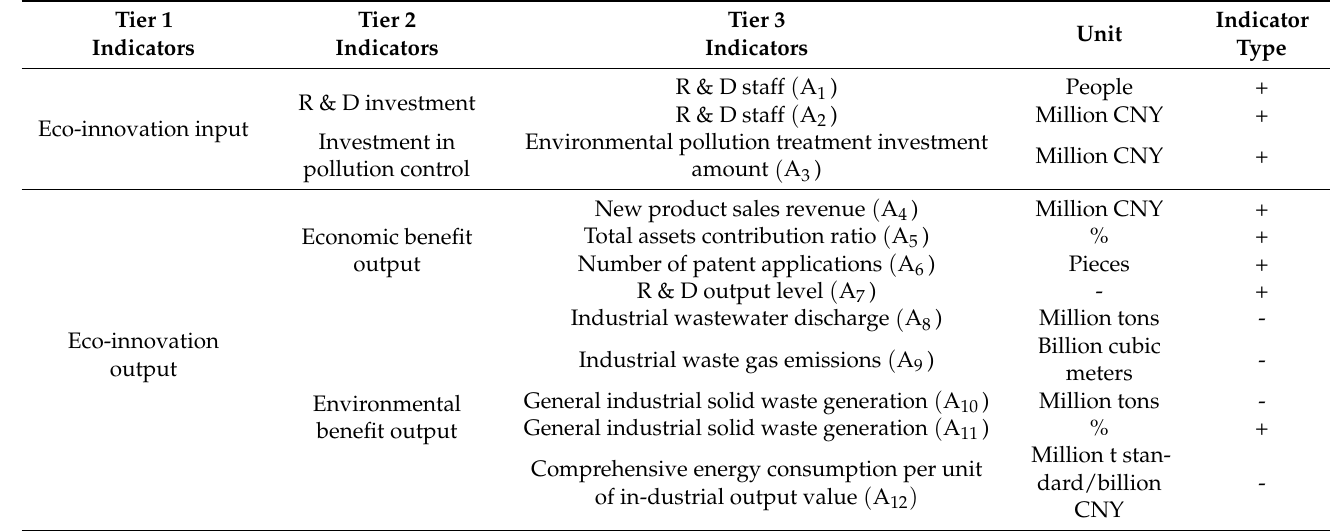
Table 1. Eco-innovation performance evaluation index system.